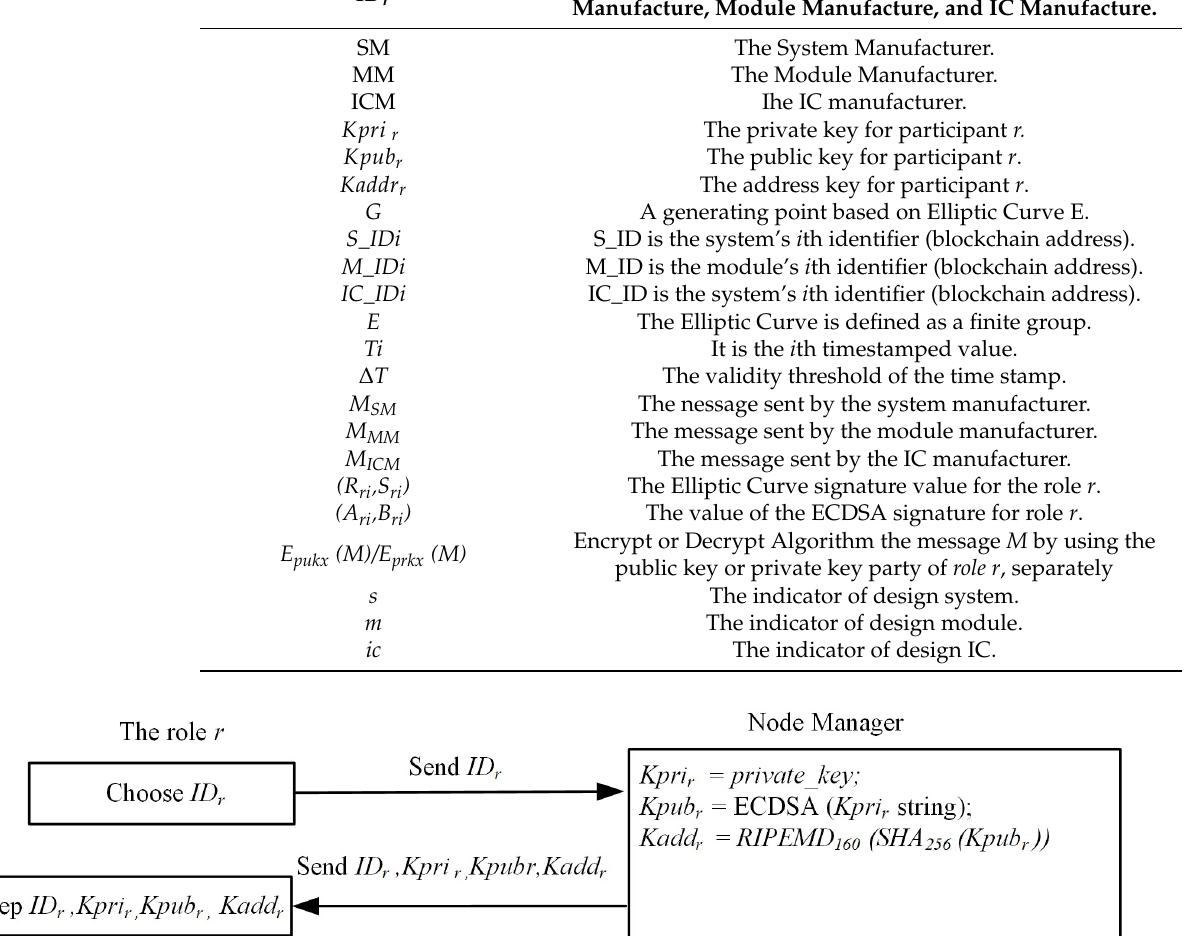
Figure 3. The registration procedure for the participant, e.g., SM, MM, and ICM.